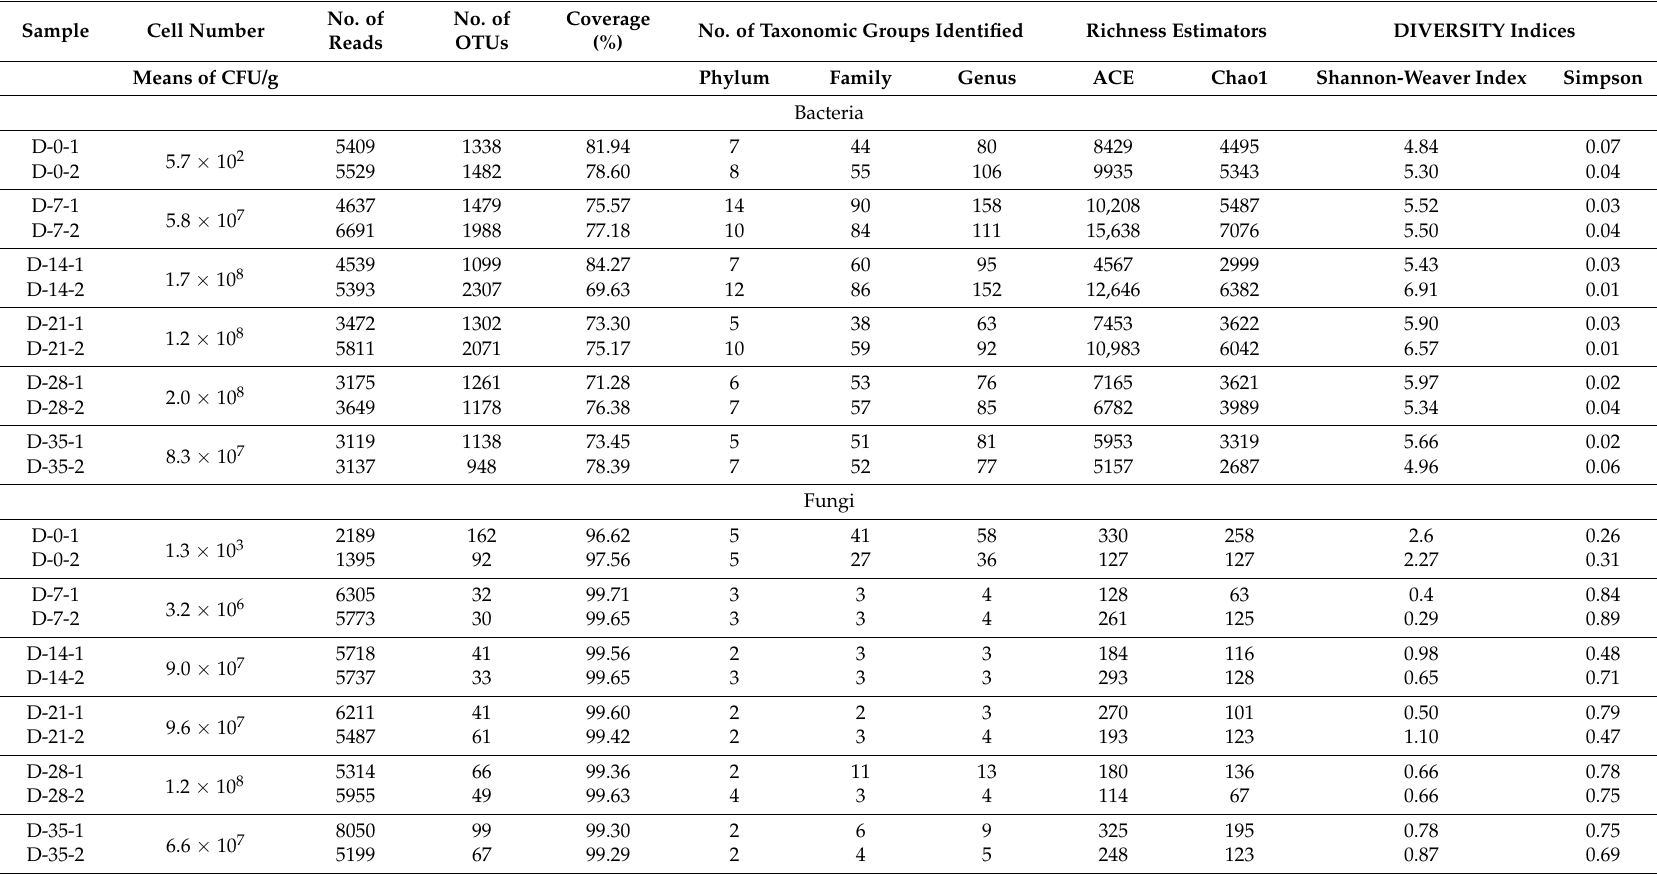
Table 2. Summary of pyrosequencing analyses of the bacterial 16S rRNA and fungal 18S rRNA